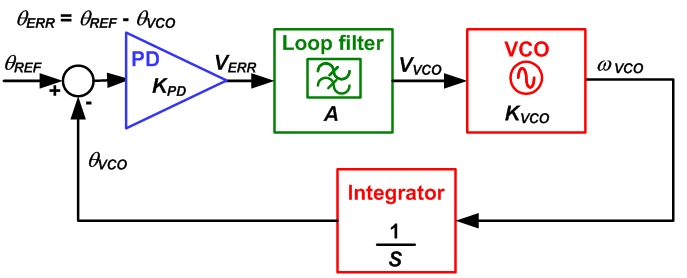
Figure 9. Block diagram of a linearized PLL.